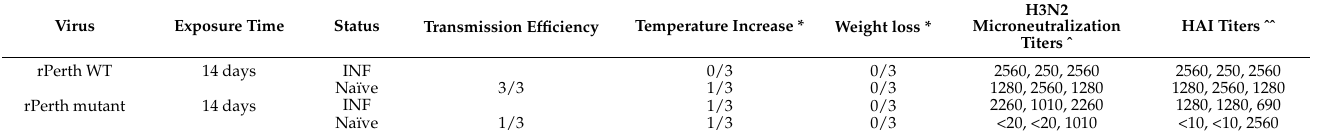
Table 1. Airborne transmission of rPerth WT and mutant